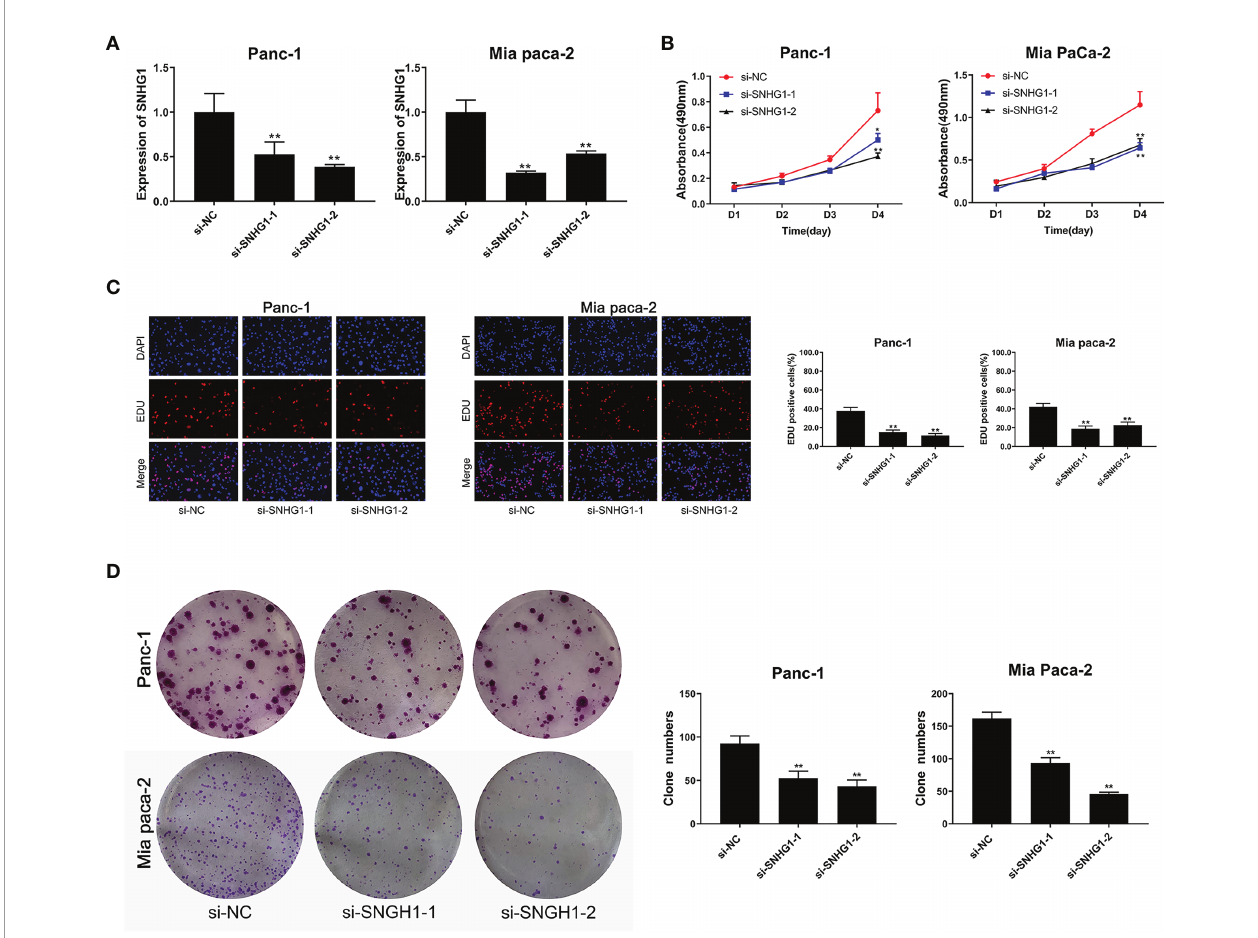
FIGURE 1 | Downregulation of SNHG1 suppresses PC cell proliferation and viability. (A) SNHG1 expression was markedly decreased in PC cells after SNHG1 silencing. (B) Downregulation of SNHG1 suppressed cell viability. (C) EDU assay showed the reduction in PC cell proliferation after SNHG1 silencing. (D) Colony formation assay showed suppression of cellular proliferation with upregulated SNHG1 expression. The data represented as means ± SD of three independent experiments. *p < 0.05, **p <